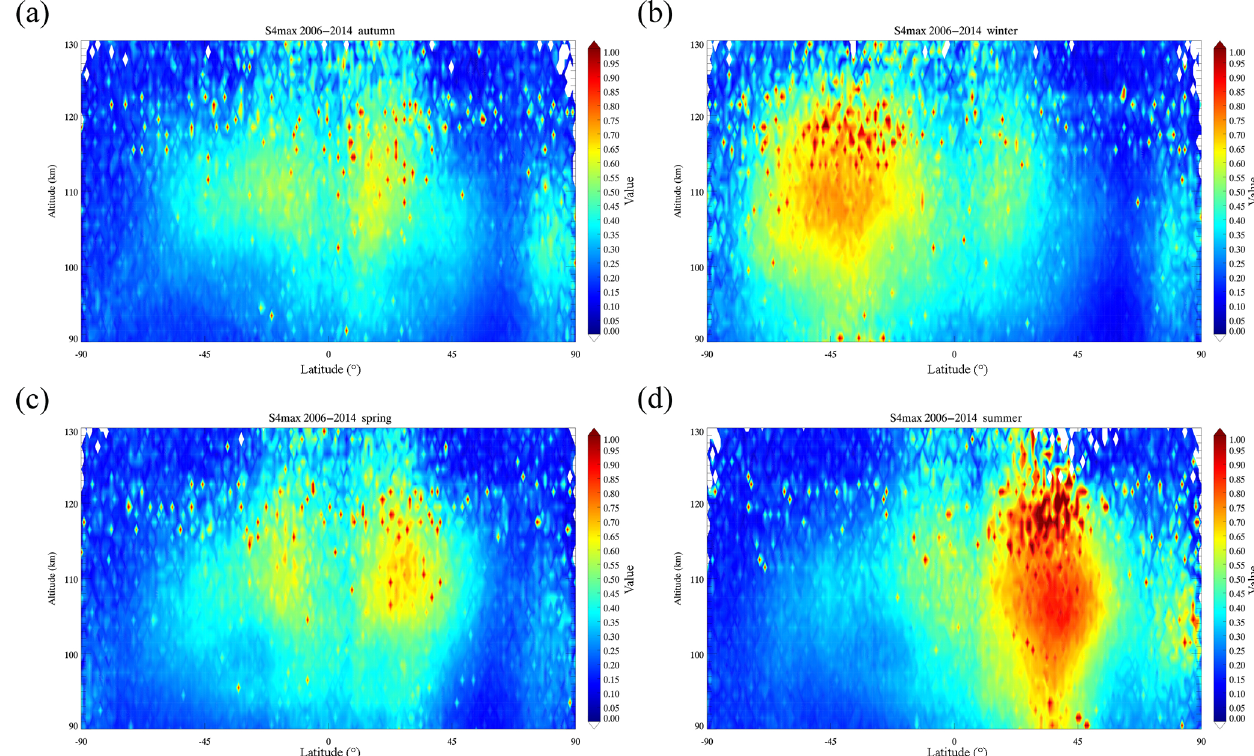
Figure 7. Seasonal variations in altitude–latitude distributions of E s intensity from 2006 to 2014 for four different seasons: (a) autumn, (b) winter, (c) spring, and (d)